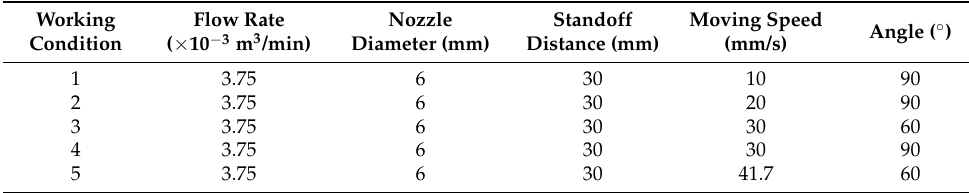
Table 8. Scouring effect at different jet angles.